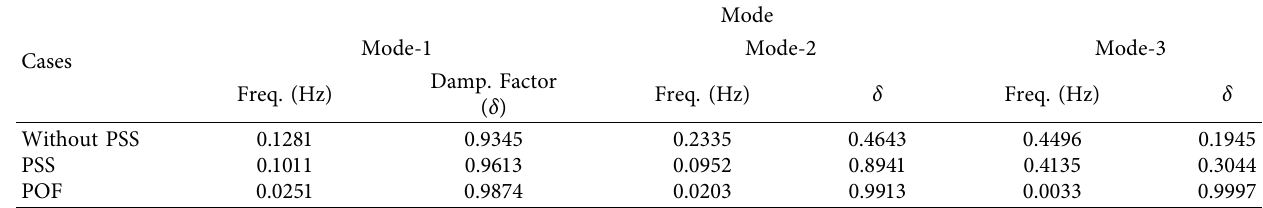
Table 1: Modal analysis without the PSS and with the PSS and POF controller.